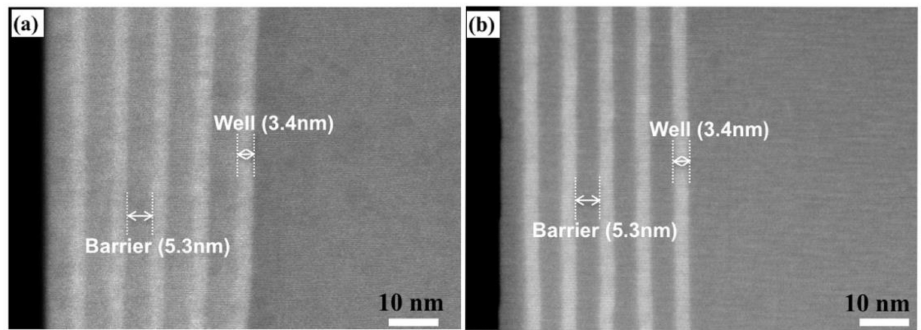
Figure 6. STEM-HAADF image of InGaN / GaN structures grown on single pattern (pitch—1200 nm, diameter—300 nm) by using ( a ) standard and ( b ) high temperature of quantum barriers, respectively.